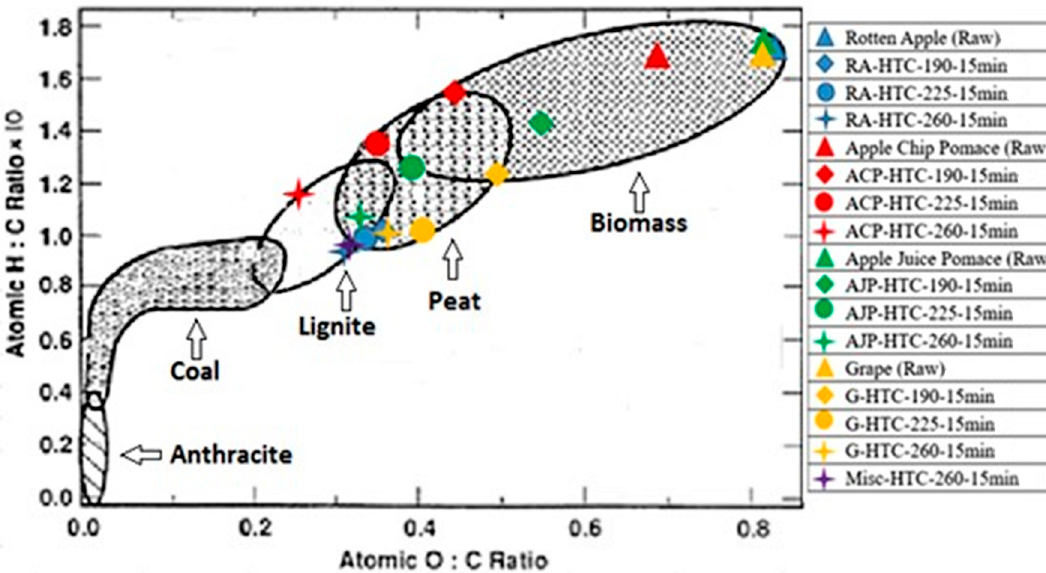
Figure 1. Atomic H/C-O/C ratios of rotten apple (RA), apple chip pomace (ACP), apple juice pomace (AJP), and grape pomace (GP), both raw and subjected to hydrothermal carbonization (HTC), compared with a traditional biomass, Miscanthus.